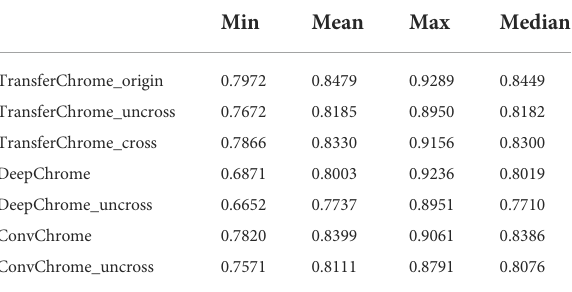
TABLE 3 Comparison of the minimum, mean, maximum, and median of the AUC scores of TransferChrome, DeepChrome and ConvChrome in single cell line and cross-cell lines gene expression predictions.